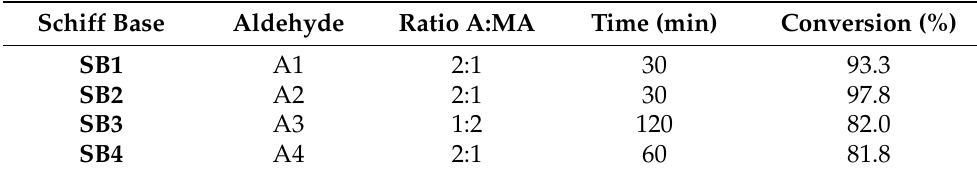
Table 1. Reaction conditions chosen for the synthesis of SB1–SB4 .